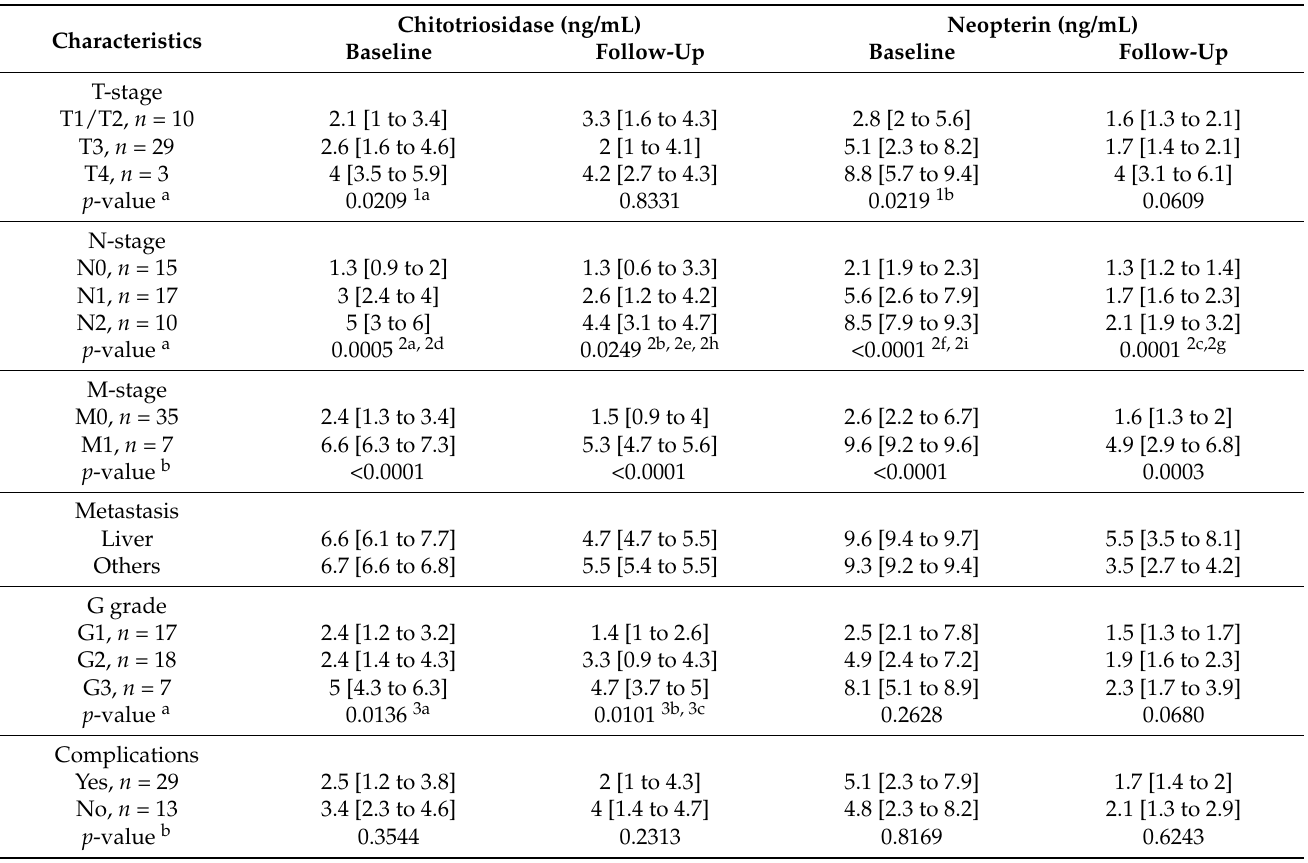
Figure 3. Chitotriosidase and neopterin: postoperative changes on patients with CRC. The × in the box indicates the mean value, the line in the box corresponds to the value of the median, the lower and upper bound of the box corresponds to the value of the first (lower) and third (upper) quartile, and the whisker corresponds to the values of minimum and maximum. The extreme values are shown as “o”. Table 5. Variation of chitotriosidase and neopterin according to different sub-groups.